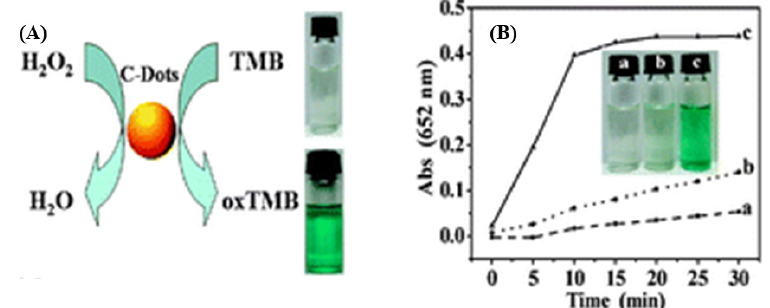
Figure 9. (A) Schematic illustration, and (B) Time-dependent absorbance of oxidized TMB by CDs at 652 nm in di ff erent systems: ( a ) TMB + CDs, ( b ) TMB + H 2 O 2 , and ( c ) TMB + CDs + H 2 O 2 —Reproduced 652 nm in different systems: ( a ) TMB+CDs, ( b ) TMB + H 2 O 2 , and ( c ) TMB + CDs + H 2 O 2 —Reproduced with permission from [87] published by The Royal Society of Chemistry, with permission from [87] published by The Royal Society of Chemistry, 2011.